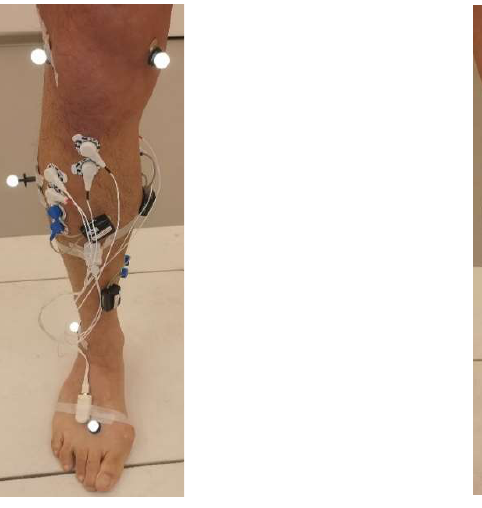
Figure 3. Oro muscles B.V. and 3D CGA sensor set-up.